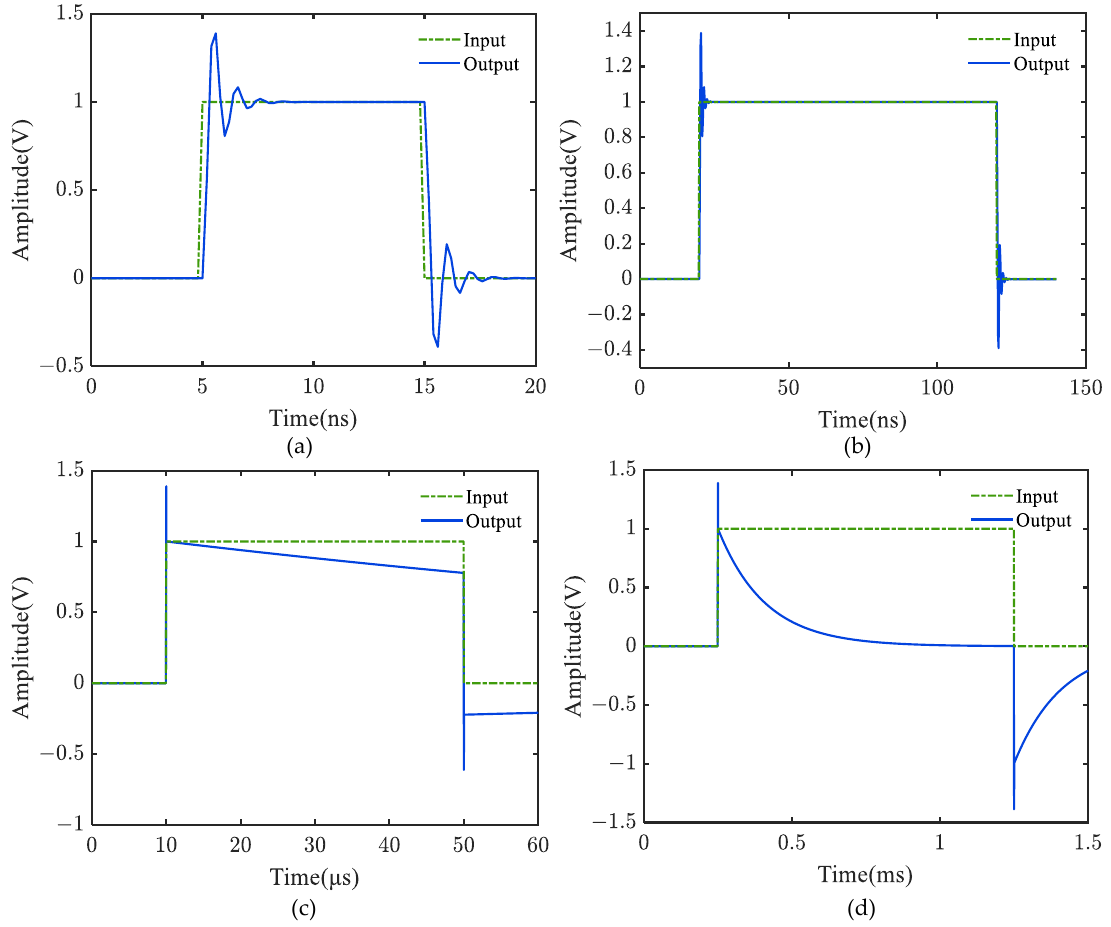
Figure 3. Square wave responses of the simulated broadband measurement system with different pulse widths. ( a ) 10 ns; ( b ) 100 ns; ( c ) 40 µs; ( d ) 1 ms.